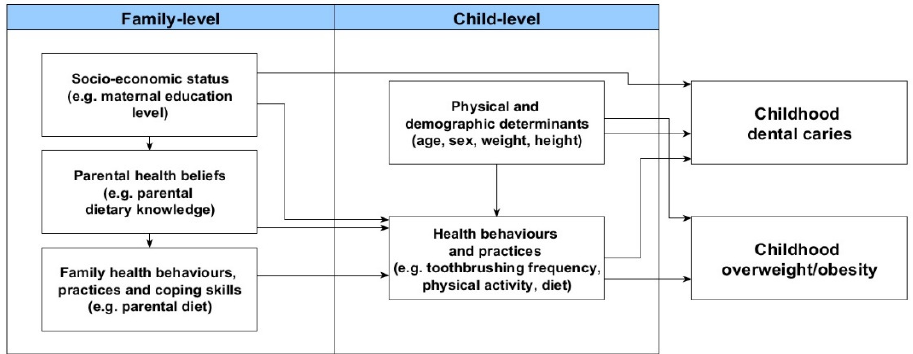
Figure 1. The adapted framework of the social determinants of dental caries and overweight/obesity in children [15].